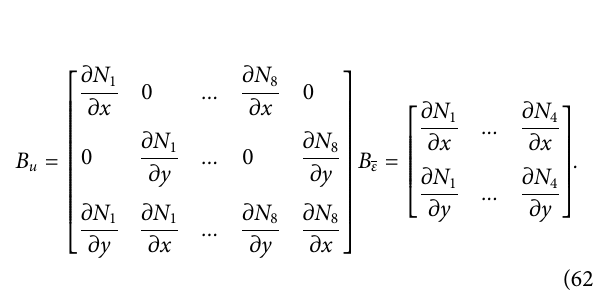
Frontiers in Materials |